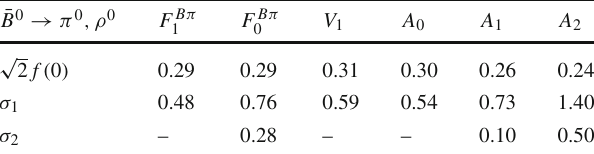
Table 1 The ¯ B 0 → M ( ∗ ) 0 transition form factors at zero-momentum transfer, with ( M A , M B ) = ( 5 . 32 , 5 . 32 ) and ( 5 . 27 , 5 . 32 ) GeV for π and ρ ,